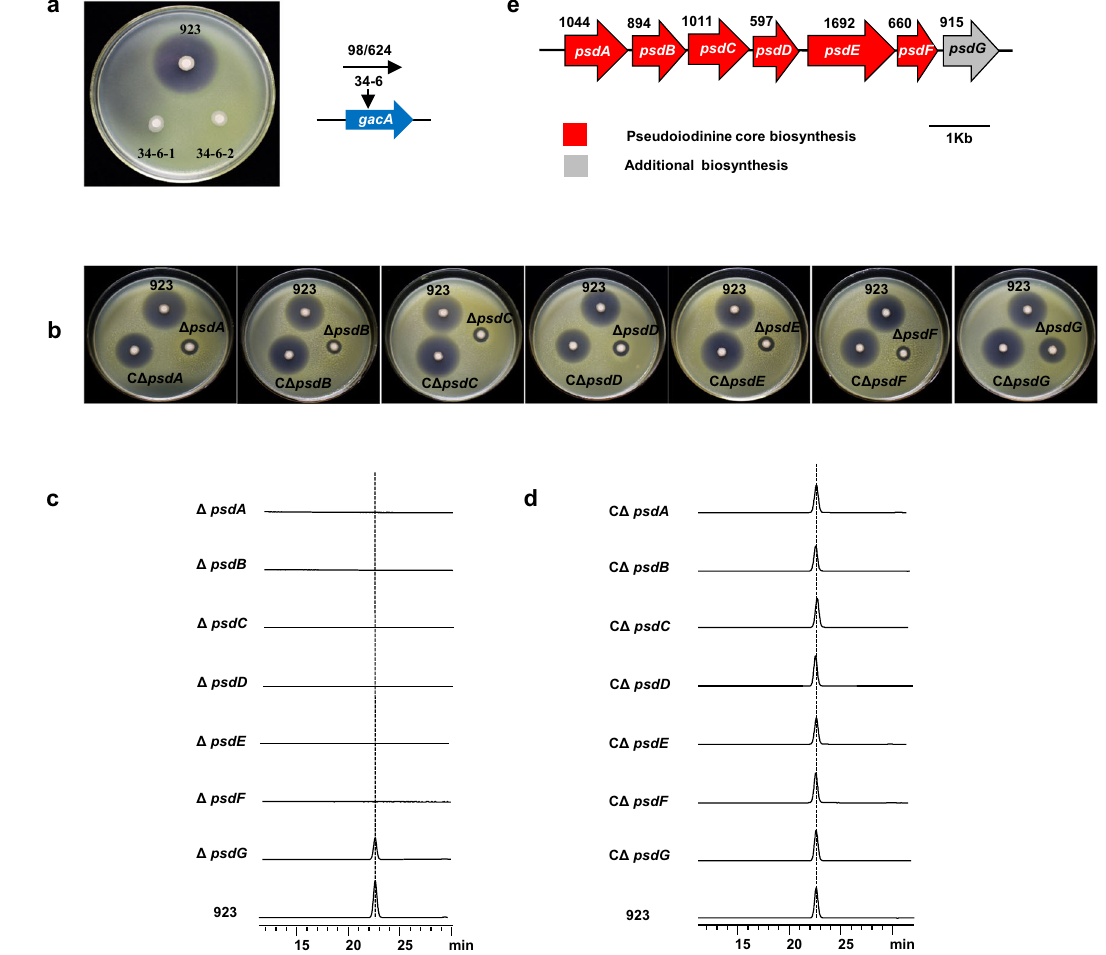
Fig. 3 | Genetic determinants ofpseudoiodinine biosynthesis. a Mutant 34 – 6 of P. mosselii 923 lacks antimicrobial activity for Xoo PXO99 A and contains a Tn5 insertion in gacA . b Antibacterial activity assays of P. mosselii 923, Δ psdA , Δ psdB , Δ psdC , Δ psdD , Δ psdE , Δ psdF and Δ psdG mutants and their corresponding com- plemented strains (C Δ psdA - C Δ psdG ). c HPLC analysis (Method B, detected at 500nm)ofmutants Δ psdA , Δ psdB , Δ psdC , Δ psdD , Δ psdE , Δ psdF, and Δ psdG . d HPLC analysis (Method B, detected at 500nm) of complemented mutants C Δ psdA - C Δ psdG . e Schematicofthe pseudoiodininebiosyntheticgene clusterin P.mosselii